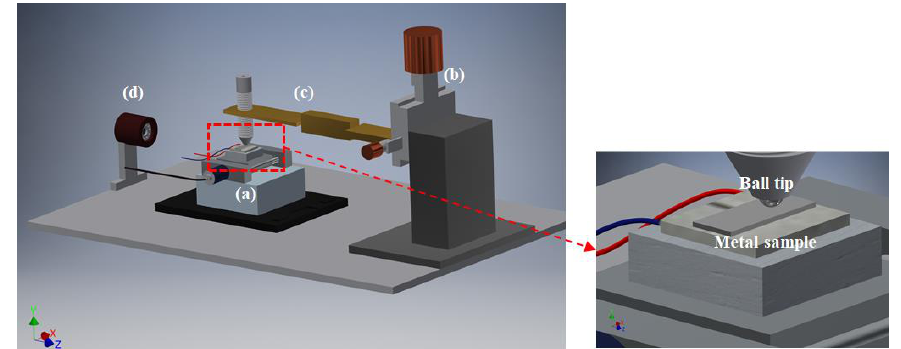
Figure 4. Reciprocating ball on disk tribometer for high temperatures: ( a ) Temperature controllable sample stage, ( b ) micro stage to adjust the normal load, ( c ) tip holder and cantilever with two strain gauges, and ( d ) high-resolution digital